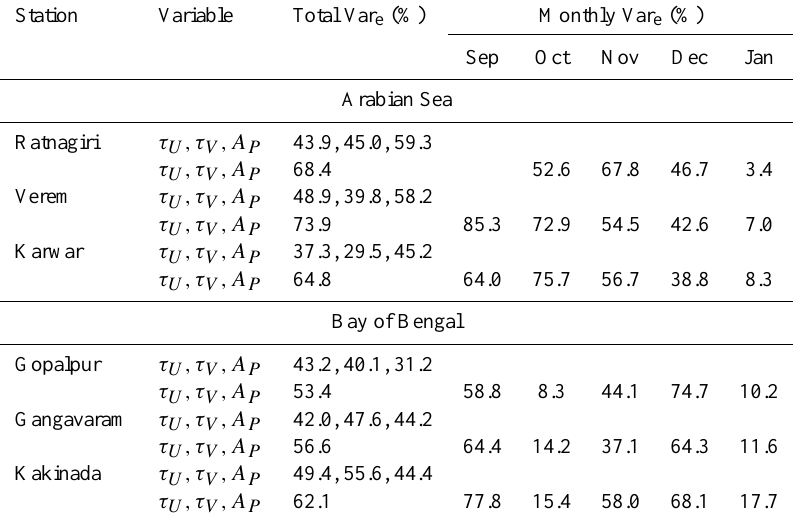
Table 4. The daily mean sea-level variability explained (Var e ) by linear ( τ U ,τ V ,A P individually) and multi-linear ( τ U ,τ V ,A P together) regression during different months from September 2011 to January 2012. Station Variable Total Var e